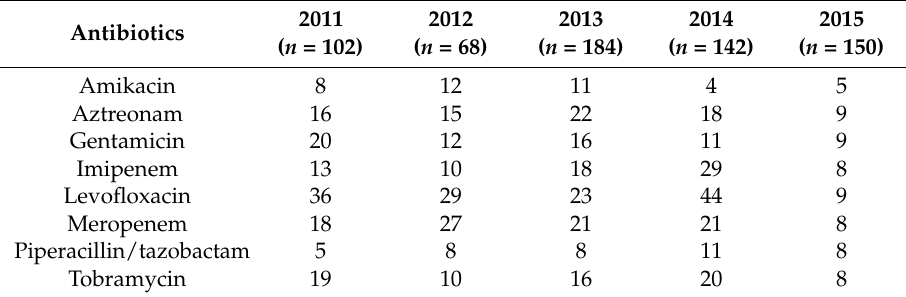
Table 1. Percentage resistance of P. aeruginosa to certain antibiotics from 2011 to 2015. Antibiotics